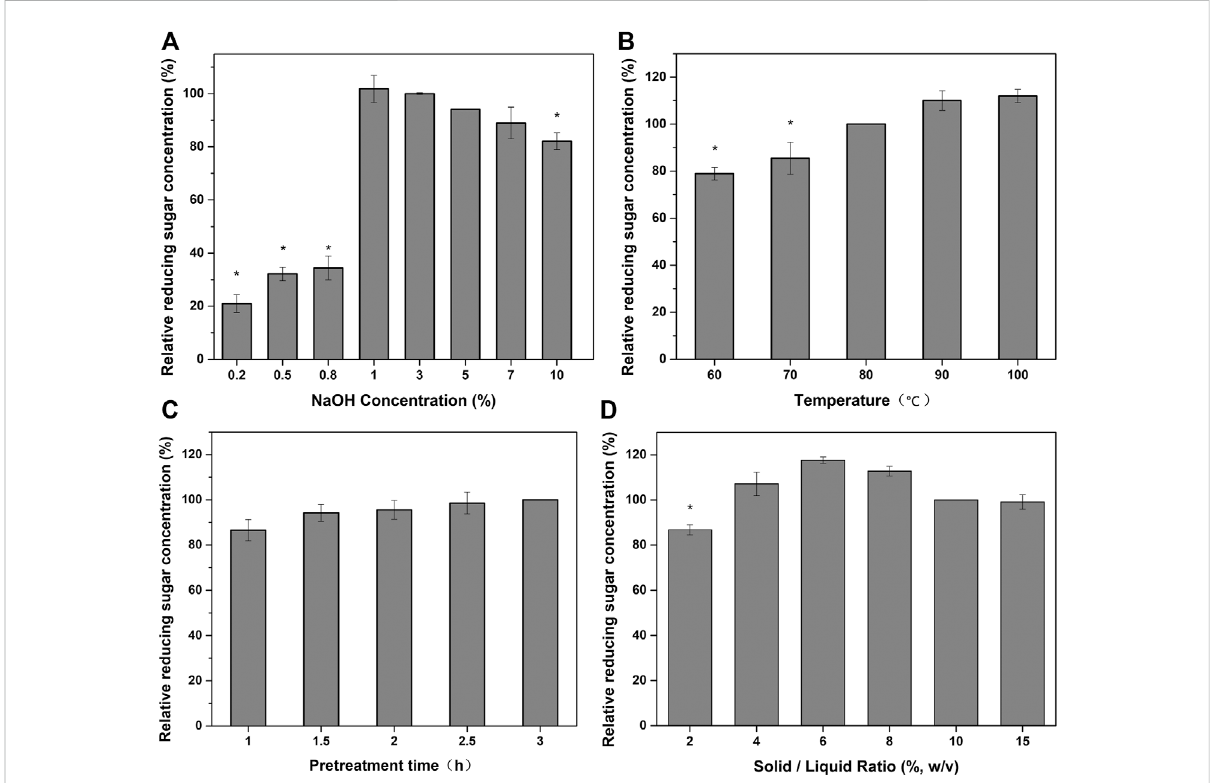
FIGURE 3 Effects of different alkali pretreatment conditions on the enzymatic hydrolysis of TSW: (A) sulfuric acid concentration; (B) pretreatment temperature; (C) pretreatment time; and (D) solid-to-liquid